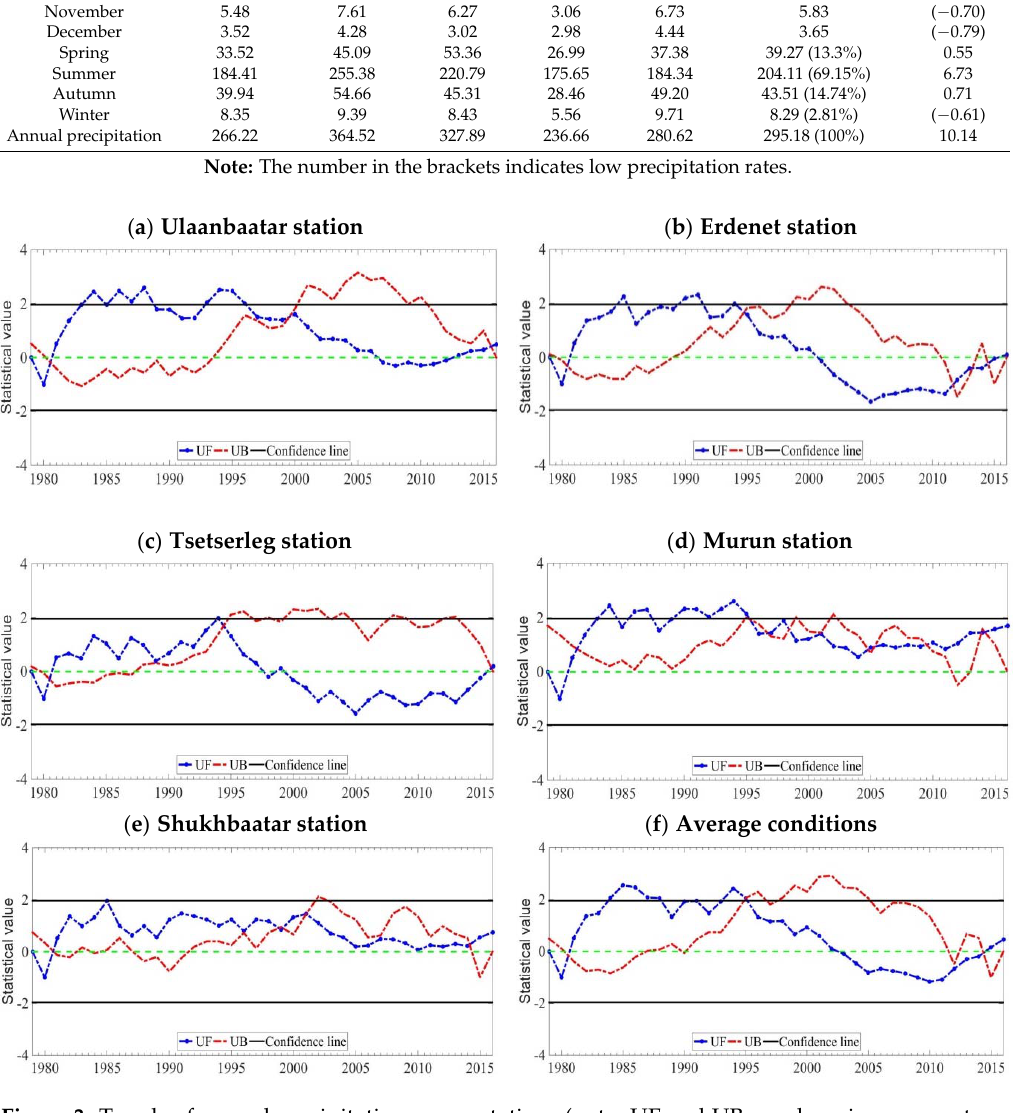
Figure 3. Trends of annual precipitation across stations (note: UF and UB are changing parameters where UB = − UF).